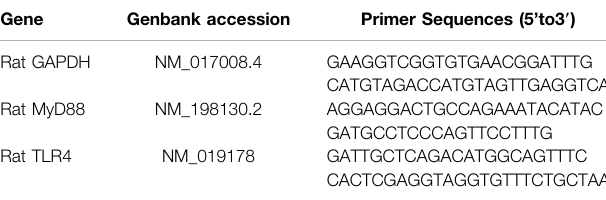
TABLE 1 | Real-time PCR